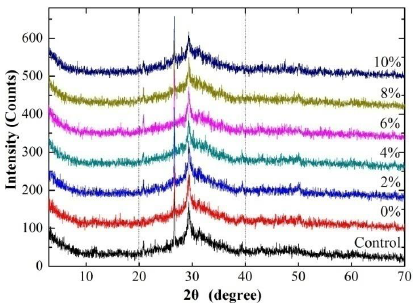
Figure 7. XRD patterns of 85 °C-cured specimens of the control and SDTSMs with different PLA dosages.